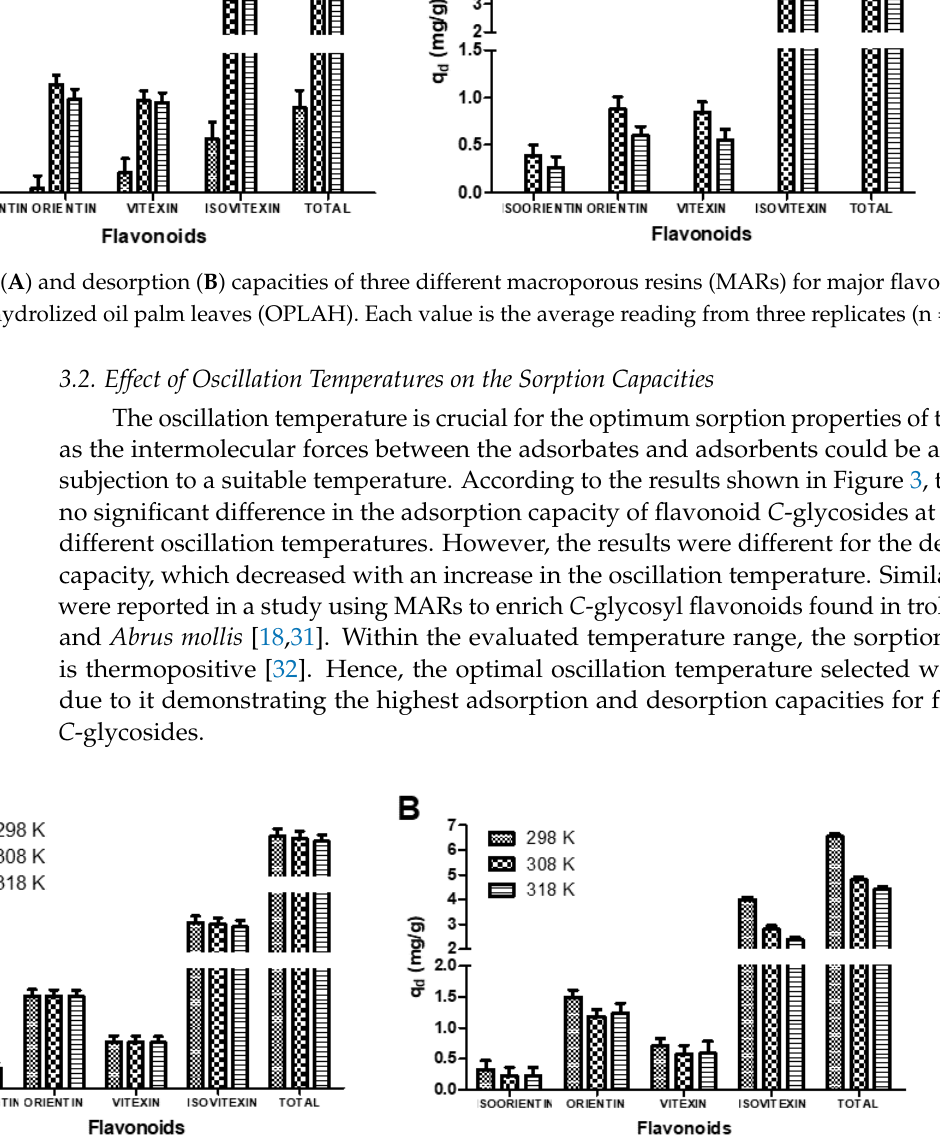
Figure 3. Adsorption ( A ) and desorption ( B ) capacities of XAD7HP resin for major flavonoid C -glycosides in OPLAH at three different temperatures. Each value is the average reading from three replicates (n = 3).